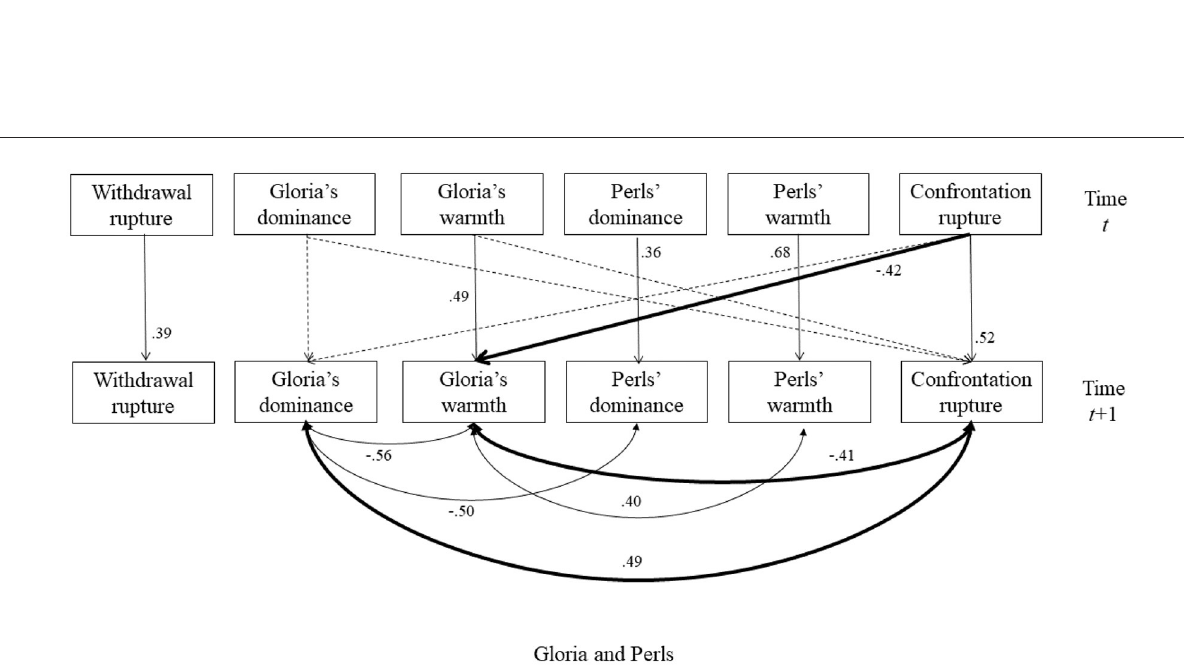
FIGURE4 The selected model for the session with Perls. The dash lines indicated non-significant autoregressive or cross-lagged regressive pathways. Significant parameters were noted next to solid lines. The double-arrowed lines indicated covariance and the single-arrowed lines indicated autoregressive or cross-lagged regressive pathways. The significant relationships between interpersonal behaviors and ruptures were